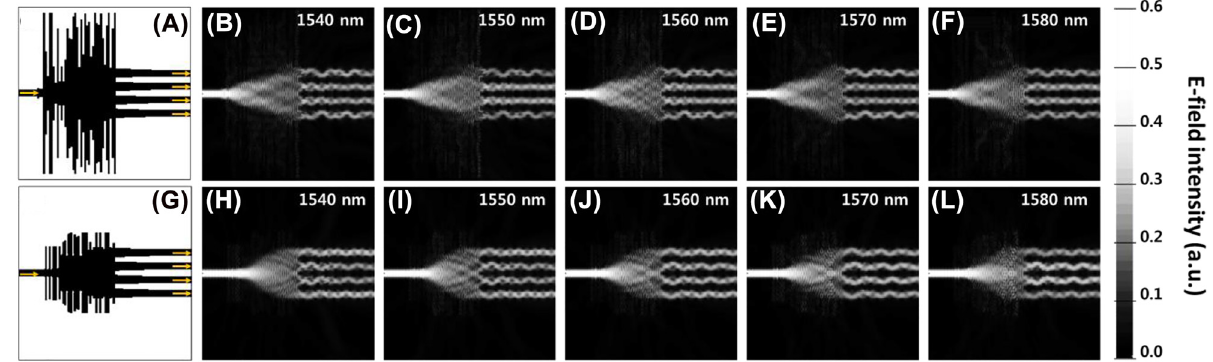
Figure 3: Designed structures of (A) OPS 1, and (G) OPS 2. Simulation results of the E-field distributions for the OPS 1 at different wavelengths, (B) 1540 nm, (C) 1550 nm, (D) 1560 nm, (E) 1570 nm, (F) 1580 nm and for the OPS 2 at (H) 1540 nm, (I) 1550 nm, (J) 1560 nm, (K) 1570 nm, (L) 1580 nm.